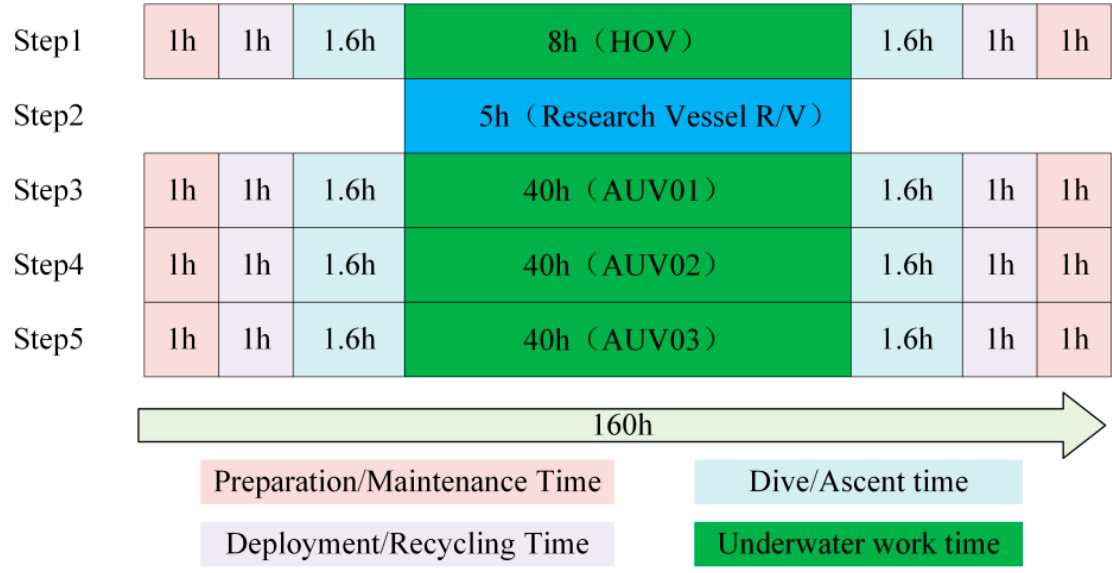
Figure 14. Elapsed time in cooperative operational mode based on a lander/USV.